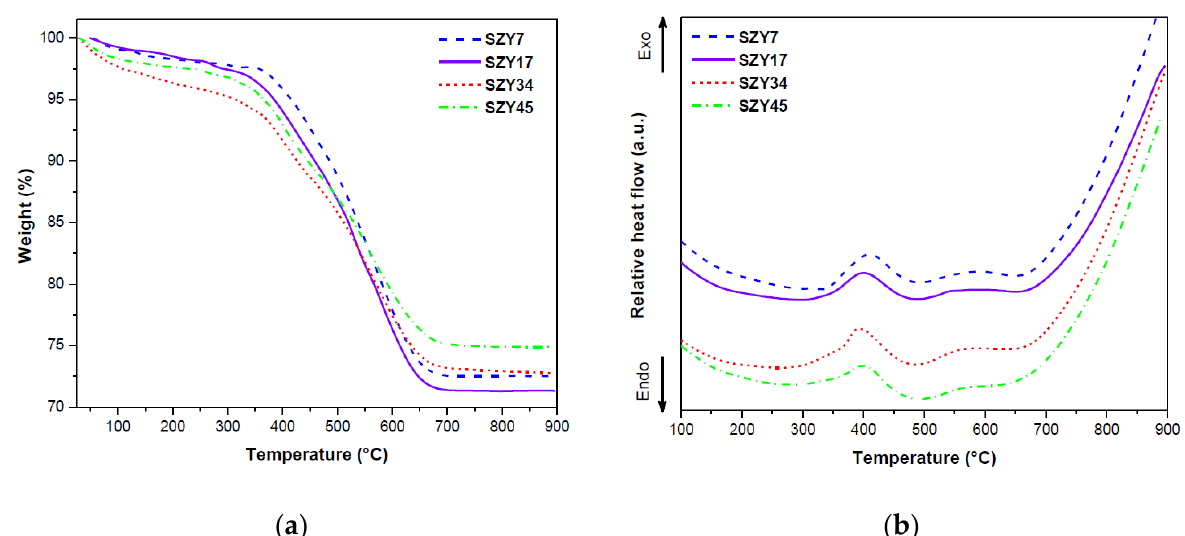
Figure 13. ( a ) Thermogravimetric analysis and ( b ) differential thermal analysis of the spent Y ‒ type zeolites.